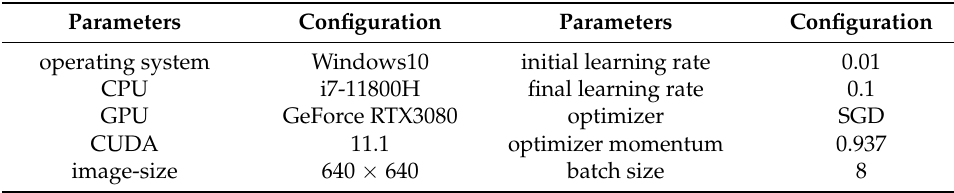
Table 2. Model parameter configuration